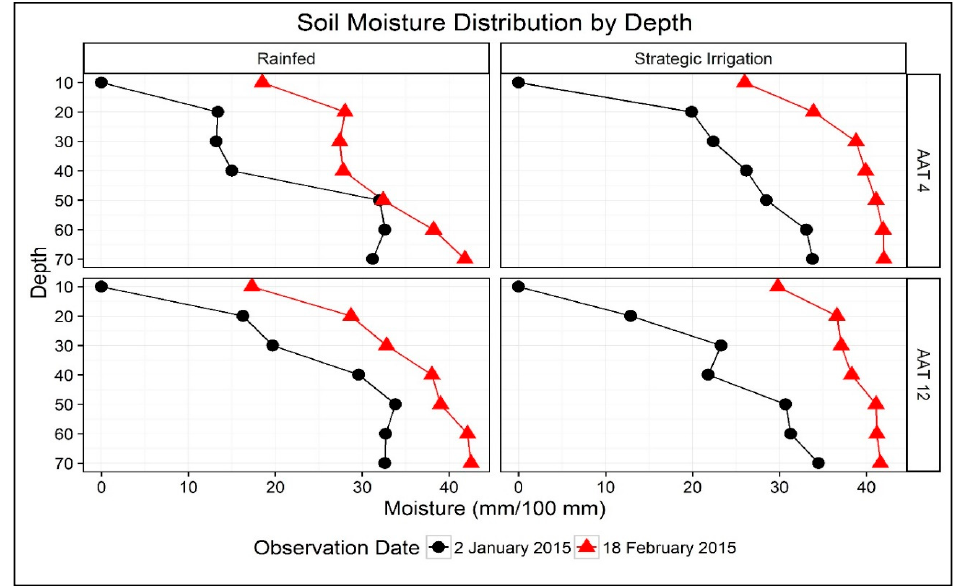
Figure 2. Soil moisture distribution (mm/100 soil depth) by depths (cm from the soil surface) for